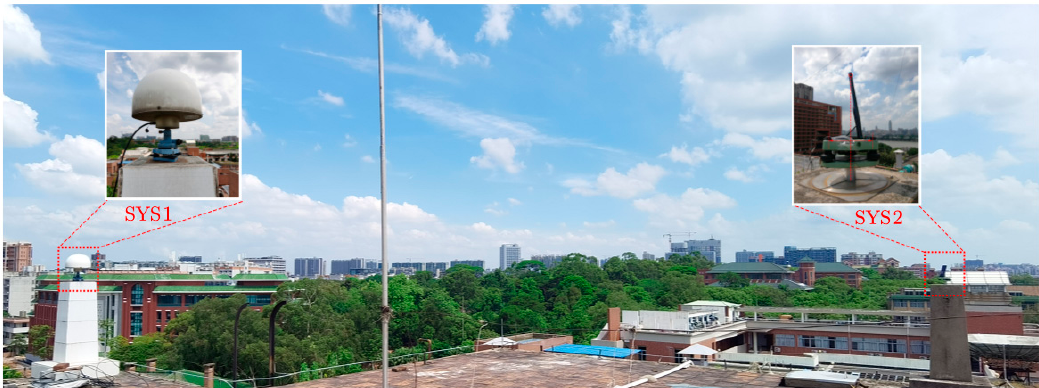
Figure 1. View of the experiment site. Left: global navigation satellite system (GNSS) antenna of the reference station on the reference point SYS1, working all days; right: the Huawei Mate30 is placed on the instrument base above the reference point SYS2 and secured with tape.